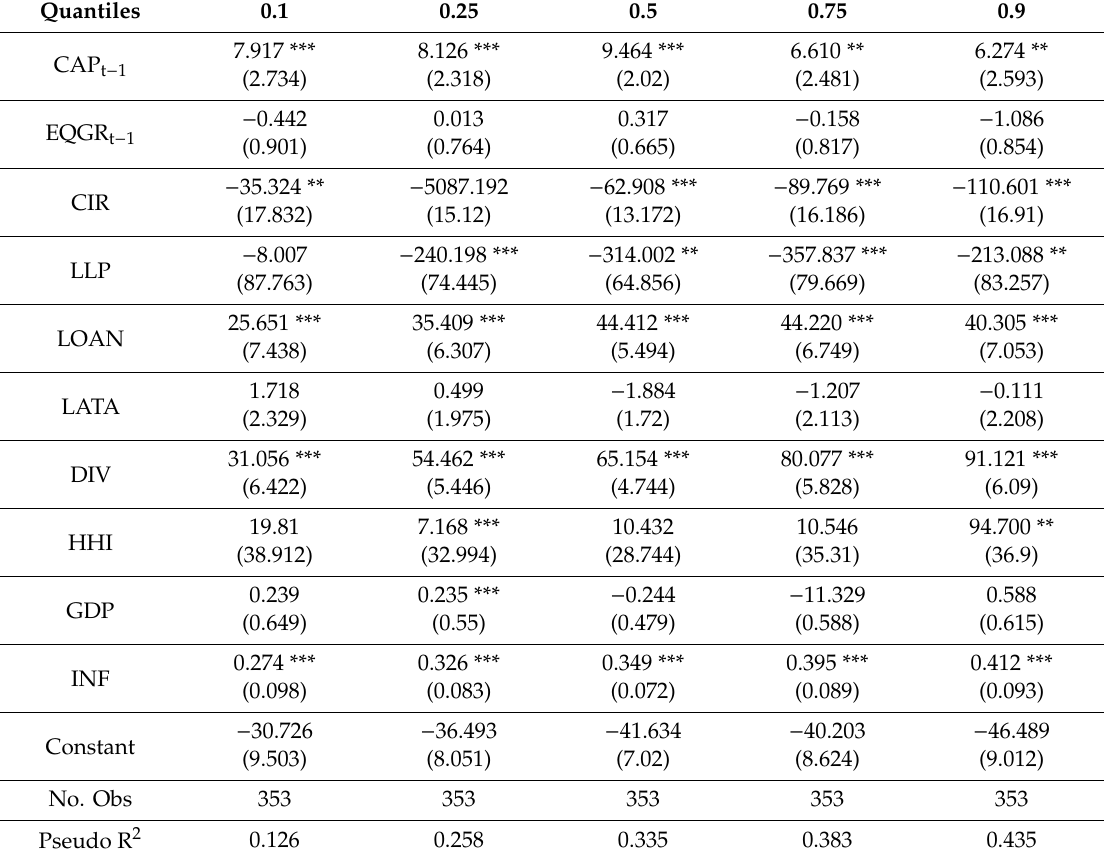
Table 5. Baseline results for ROE: quantile regressions.